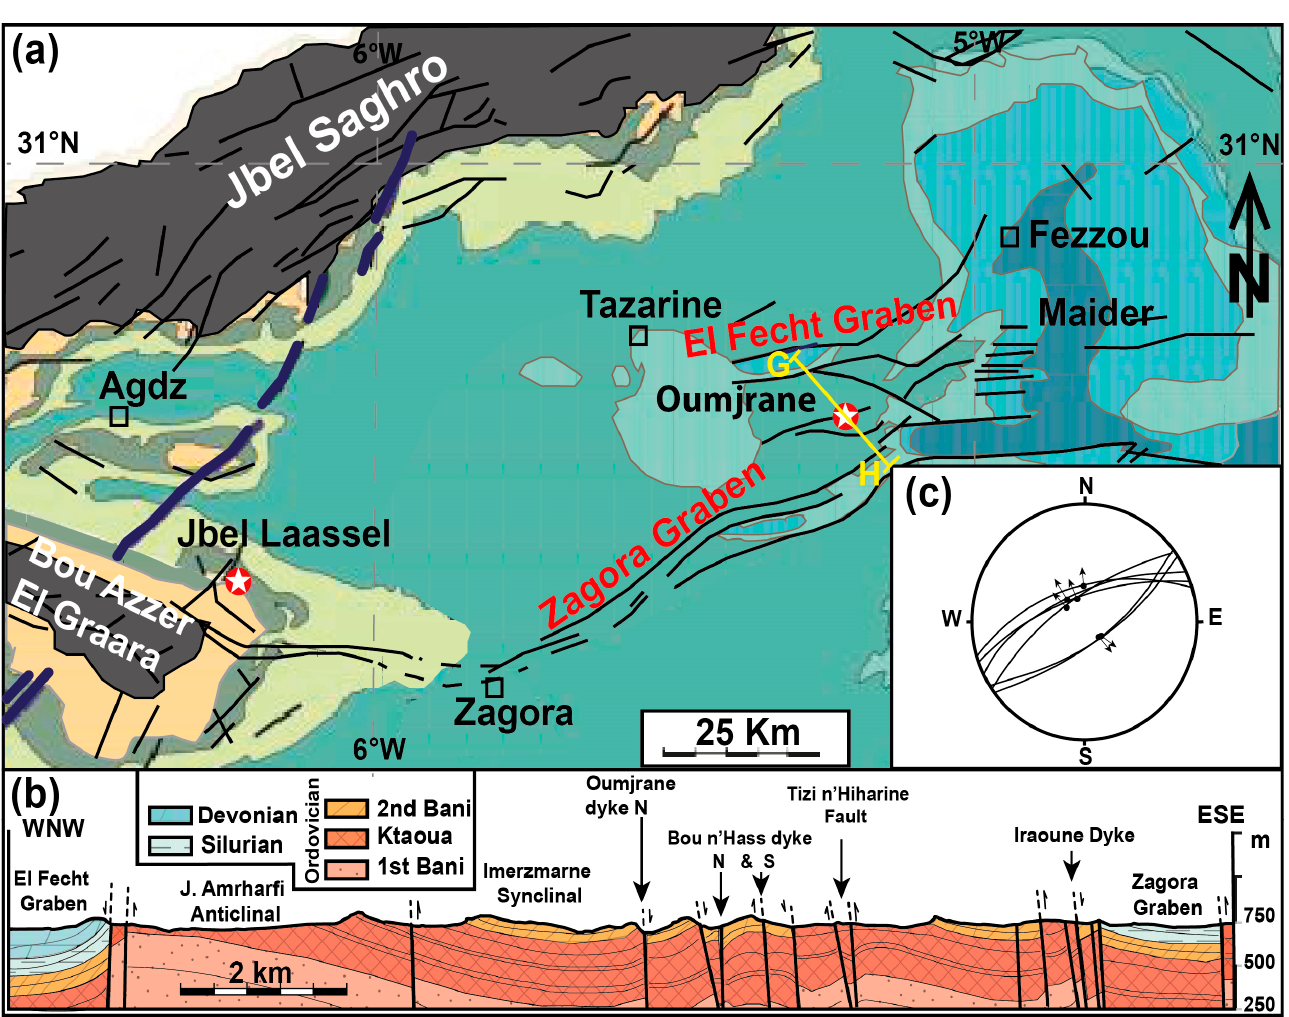
Figure 8. ( a ) Structural diagram showing the two major structures of the Zagora and El Fecht grabens (same legend as Figure 1), compiled from the geological maps of “Zagora-Elbow of the Drâa-Hamada of the Drâa” and “Todrha-Ma’der” at 1/200,000. ( b ) Geological cross-section (section G-H) of the Oumjrane-Bou n’Hass district (modified after Kharis et al. [90]). ( c ) Stereogram of normal fault planes (Schmidt canvas, lower